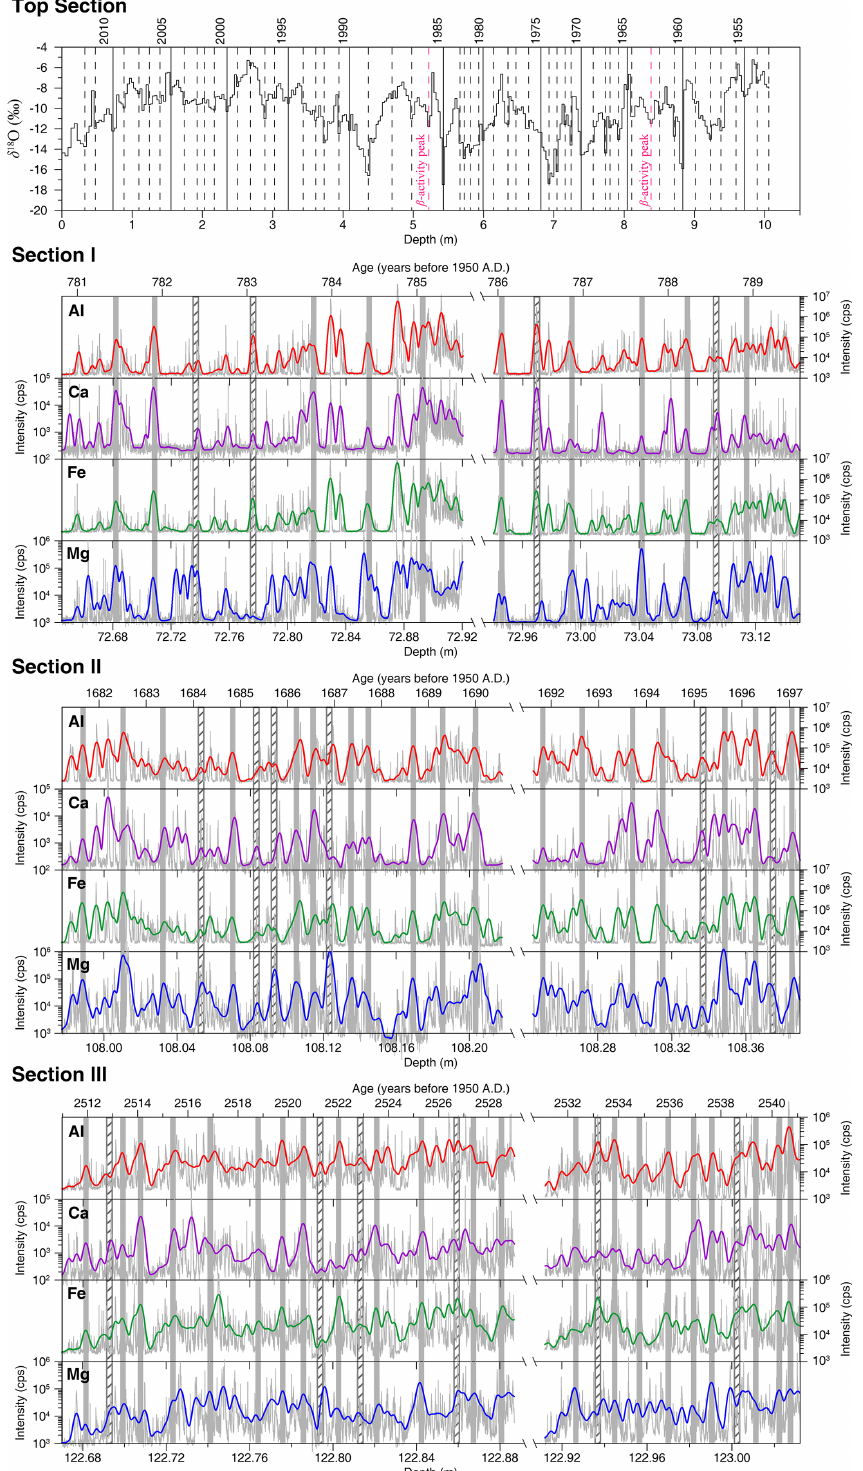
Figure 2. Annual layer counting for the Top Section and Section I, II, and III (top to bottom). The annual layers of the Top Section are identified based on the seasonality of δ 18 O and two β activity peaks (An et al., 2016). The annual layers of Section I, II, and III are marked at the winter and spring peaks (grey bars) of Al, Ca, Fe, and Mg concentrations. The open grey bars filled with forward slashes indicate uncertain annual layers. Thin grey lines indicate raw data, and thick colored lines represent 200-point Gaussian smoothing. LA-ICP-MS intensity is reported in counts per